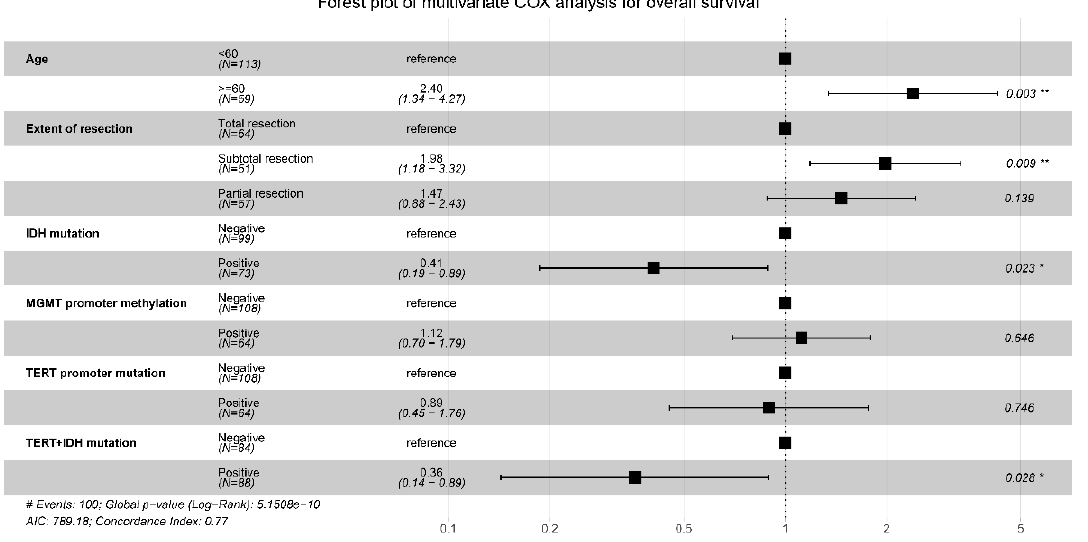
Figure 3. Forest plot for the multivariable COX analysis of OS. Age, extent of resection, IDH mutation, and IDH and TERT promoter co-mutation were identified as the significant prognostic factors for OS. * p < 0.05,** p < 0.01.